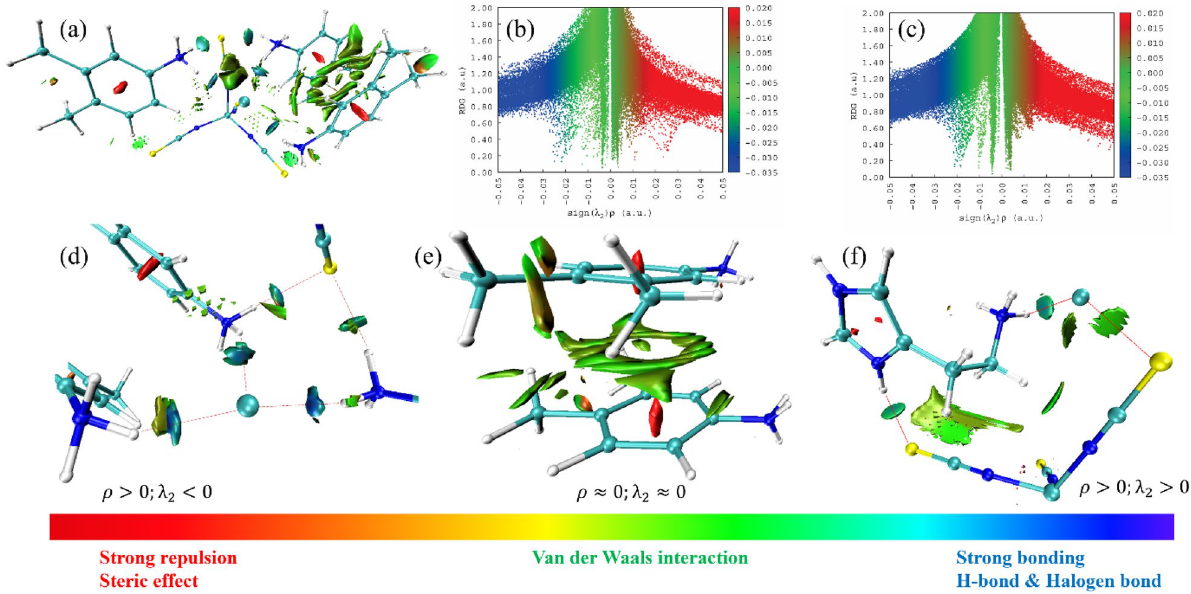
Figure 17. Non-covalent interaction isosurface map and their RDG